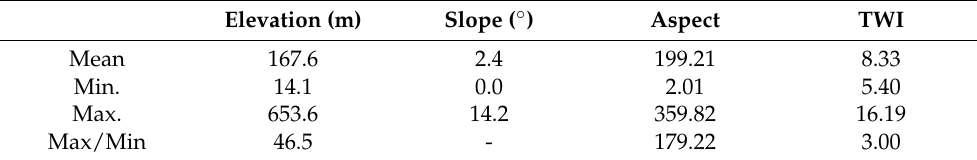
Table 2. Elevation, slope, aspect, and local topographic wetness index (TWI) of the research plots.